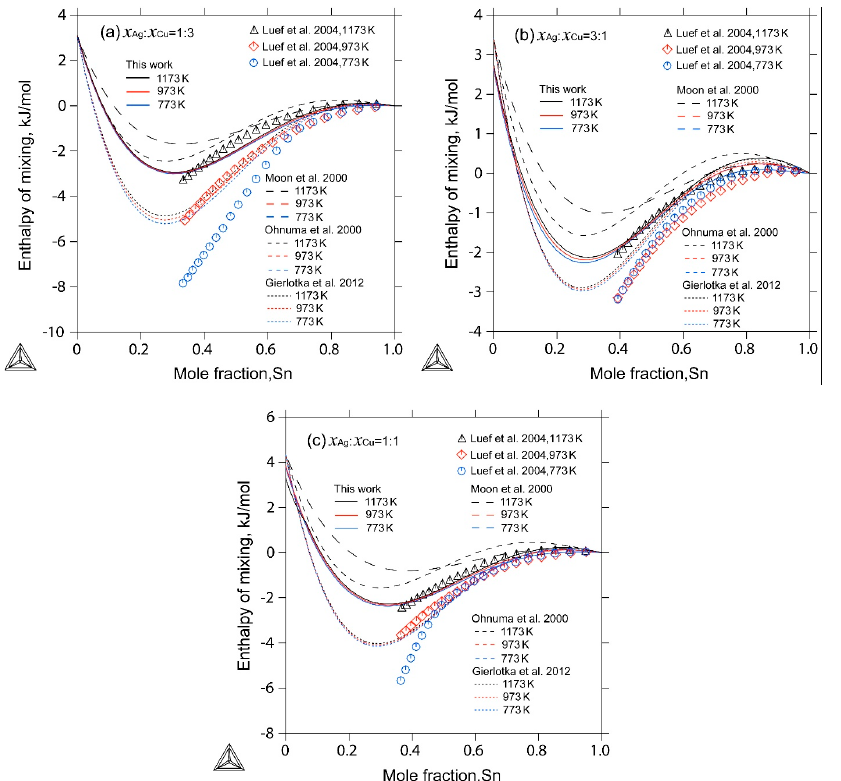
Figure 7. Comparison of the calculated enthalpies of mixing of Ag-Cu-Sn liquid alloys with the experimental data from [30] and the calculated results from [21,24,28] at 773 K, 973 K and 1173 K (referenced states: liquid Ag, liquid Cu and liquid Sn). ( a ) x Ag : x Cu = 1 : 3; ( b ) x Ag : x Cu = 3 : 1; ( c ) x Ag : x Cu = 1. Figure 8 is the calculated activity of Sn in liquid Ag-Cu-Sn alloys at 1000 K and 1300 K with the experimental data determined by Kopyto et al. [31] and the calculated results [21,24,28]. It was shown that the calculated results in this work (solid line) are reasonably consistent with the experimental data [31] and are better than the calculated results [21,24,28].